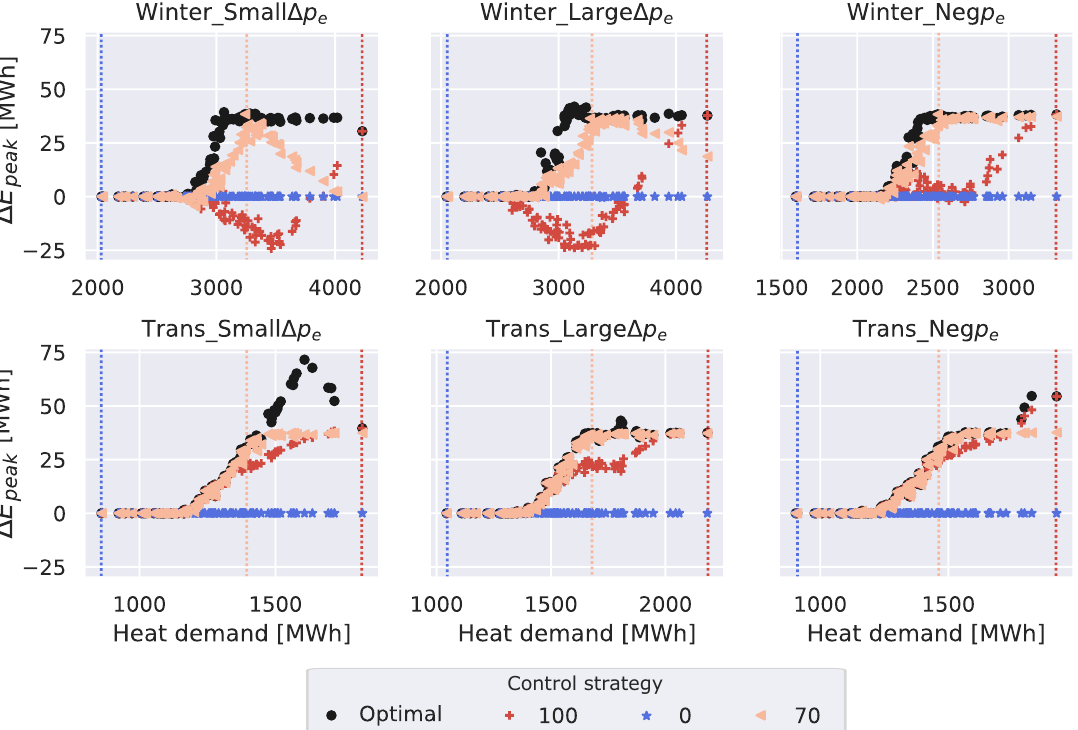
Figure 12. On the x -axis the total heat demand during each day and each version is shown, on the y -axis the peak energy that was avoided with a control strategy. Every dot represents one version of GenkNET managed by a different control strategy. The vertical dotted lines show the heat demand that corresponds to the shown control